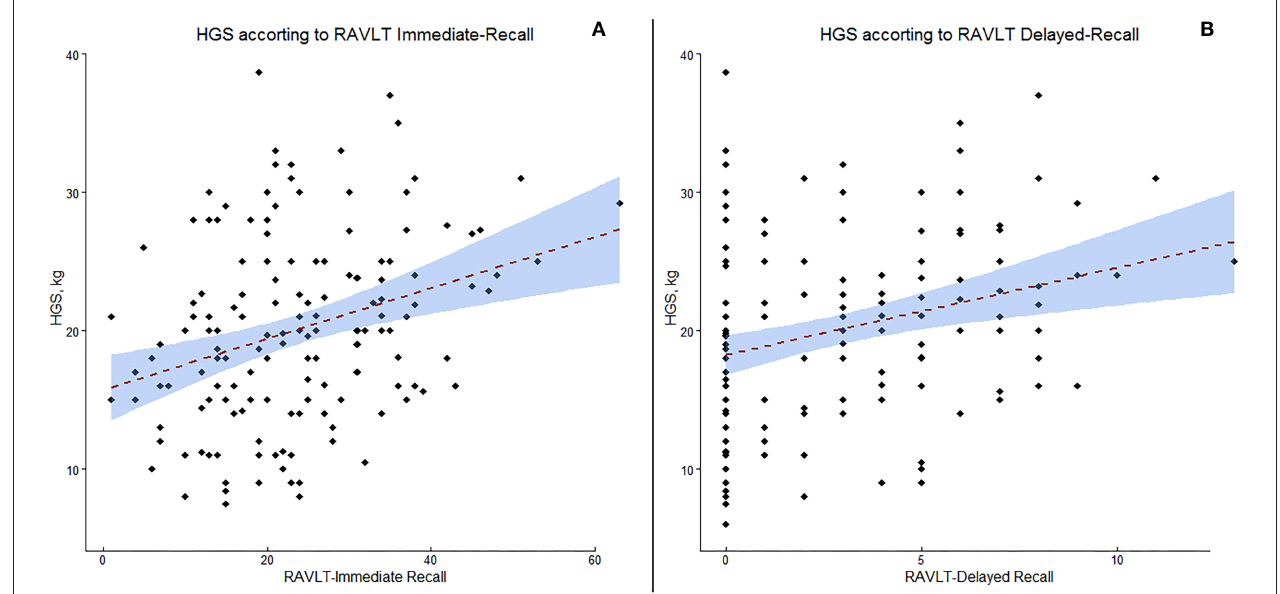
FIGURE 2 | Scatter plot of the correlation between handgrip strength (HGS) and Rey Auditory Verbal Learning Test (RAVLT) immediate recall (A) and delayed recall (B) .